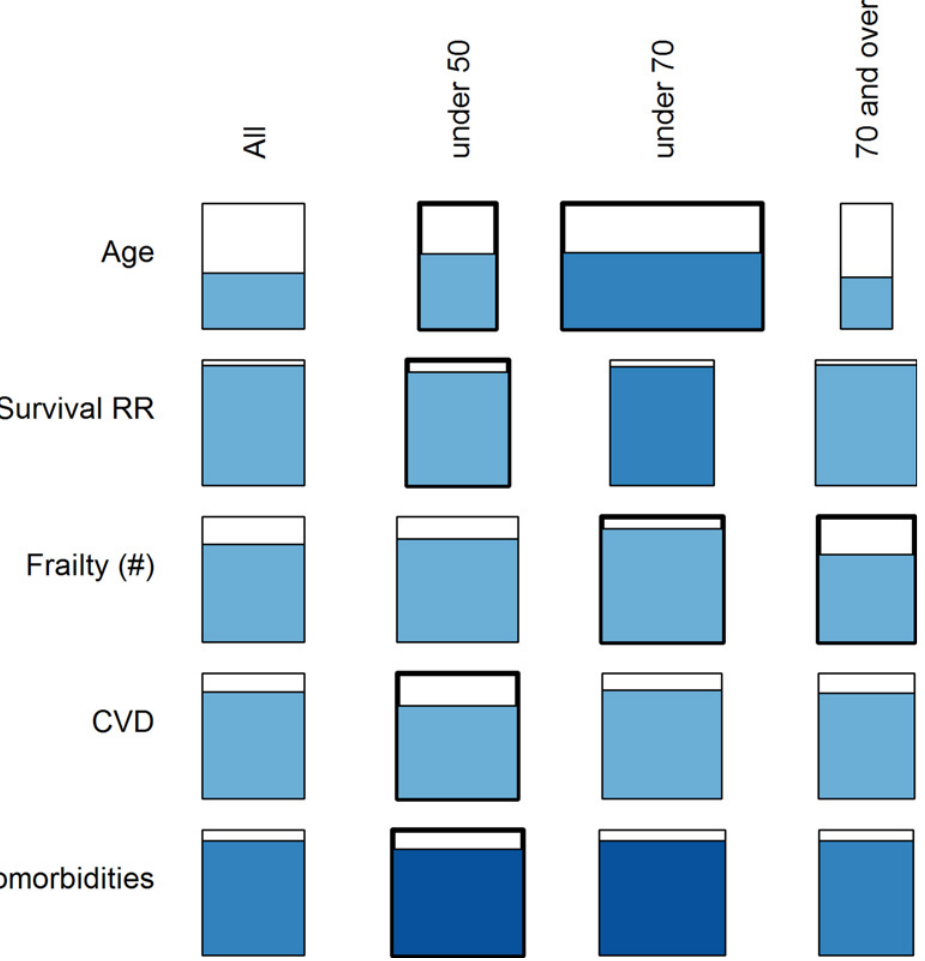
Fig 6. Effects of RP age intervals on prediction of age and health outcomes. The study population represented here is the full InCHIANTI data set with InCHIANTI RPs covering different age intervals. The width of the rectangle represents the average effect size among significant analyses, relative to the effect size of the rectangle in the leftmost column (entire study population as its own RP). The percentage of significant p-values is represented by the height of shading within the rectangle, the shading colour represents the direction of the effect (blue is a positive effect), and the hue represents the average p -value among the significant p-values, with darker hues indicating lower p